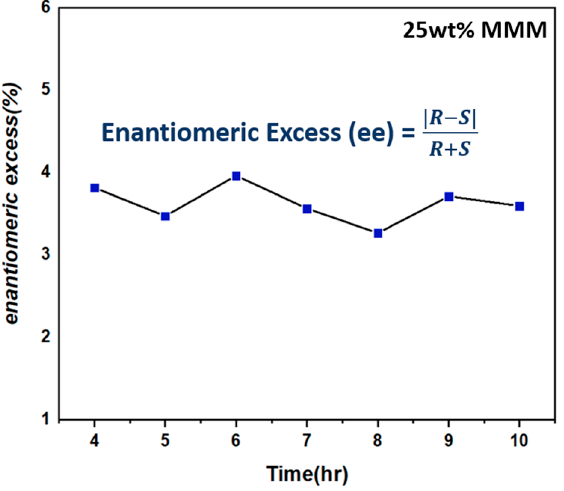
Figure 9. Enantiomeric Excess for (R)-1-phenylehtanol over (S)-1-phenylethanol .